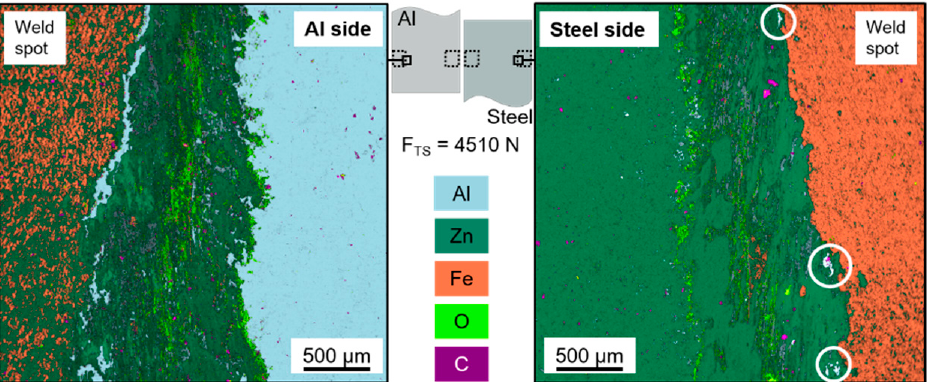
11 of 14 Figure 8. SEM images including EDX spot measurements of the fractured surfaces after tensile shear tests for ( a ) parallel and ( b ) series configuration.